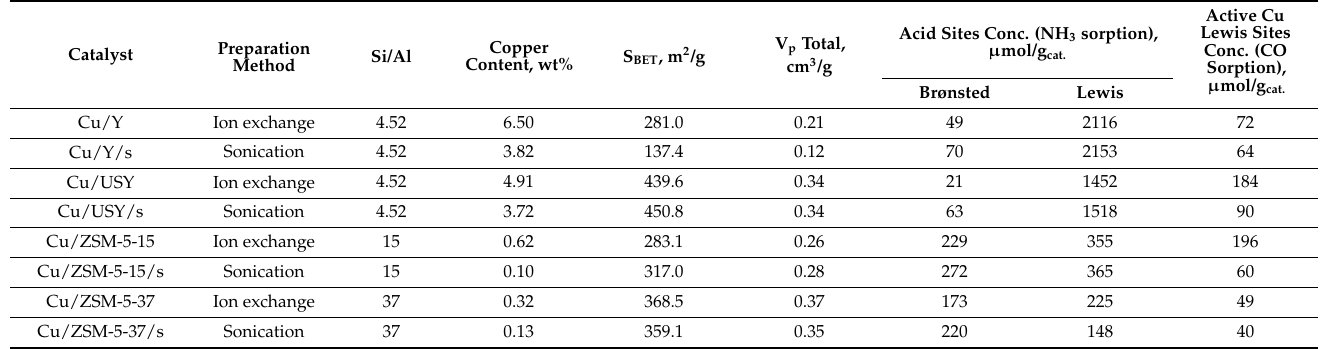
Table 1. Catalysts and their physicochemical